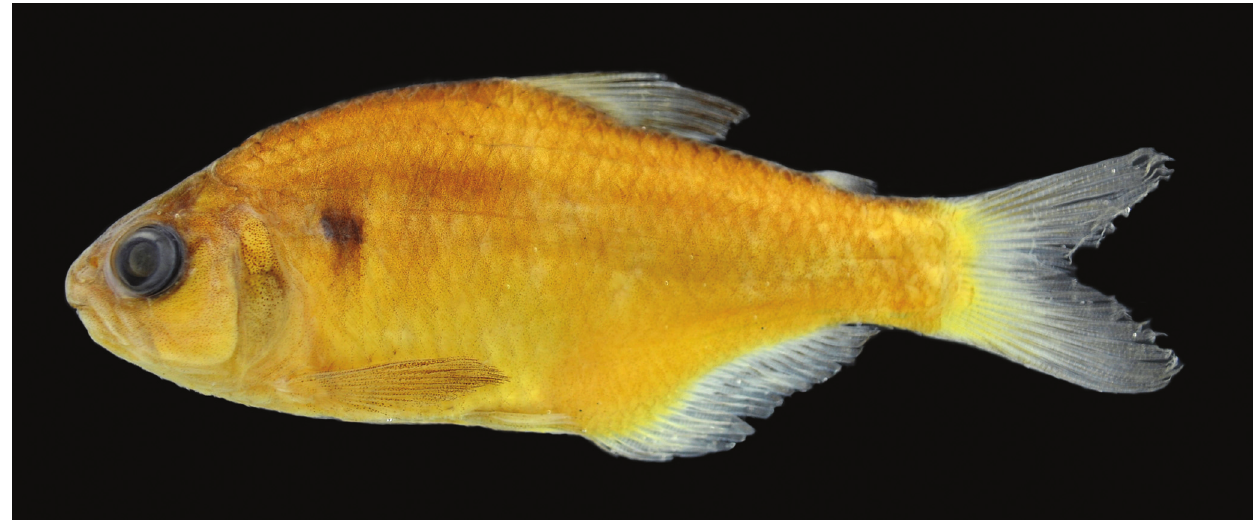
Fig. 1. Carlastyanax aurocaudatus , CI-FML 5015, 46.2 mm SL. Alcohol-preserved